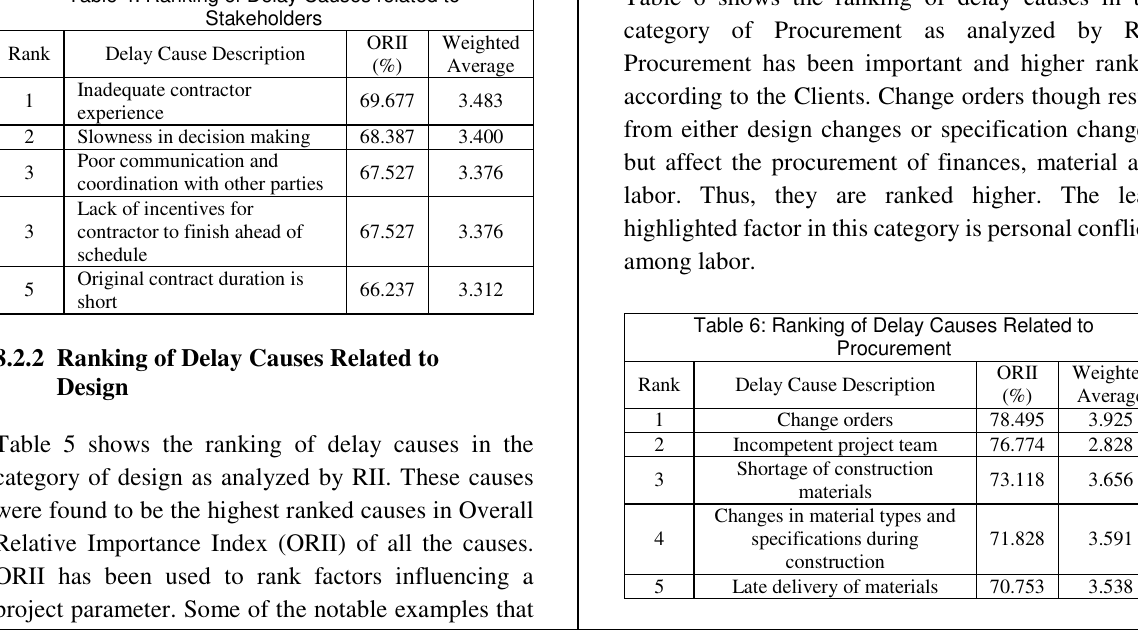
Table 4: Ranking of Delay Causes related to Stakeholders